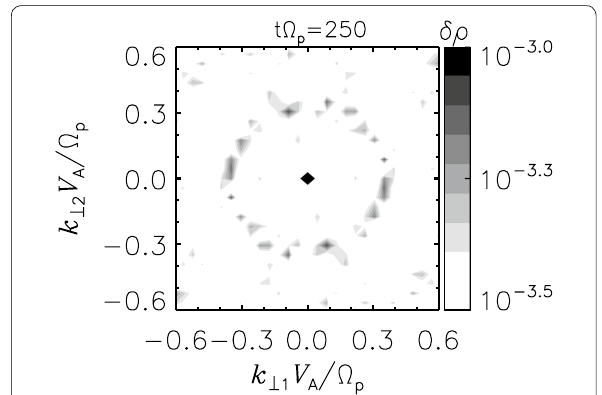
Fig. 3 Ring-shape structure generated in the density perturbation at a time of t Ω p =